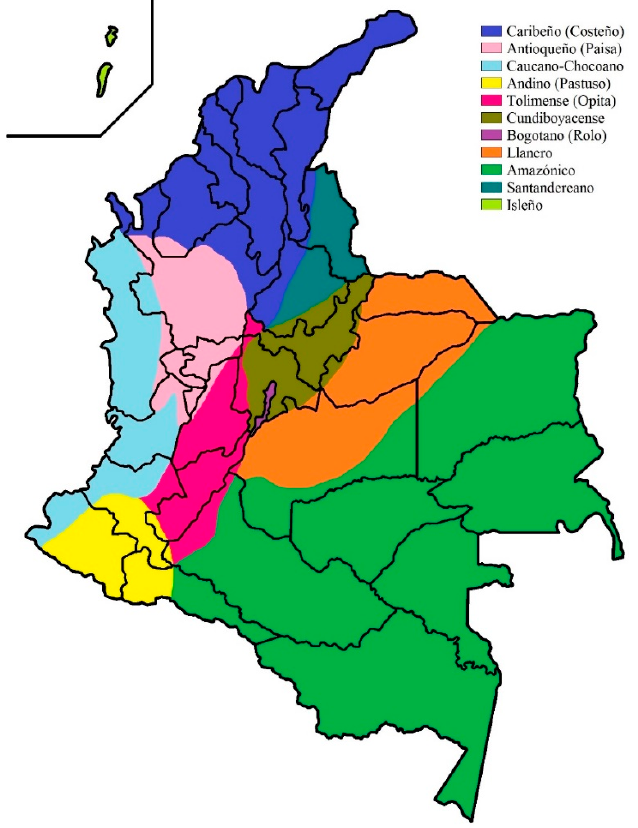
Figure 3. Regions and dialects in Colombian Spanish. Available online: https://thebogotapost.com/understanding-colombias-different-accents/27454/ (accessed on 20 November 2021).